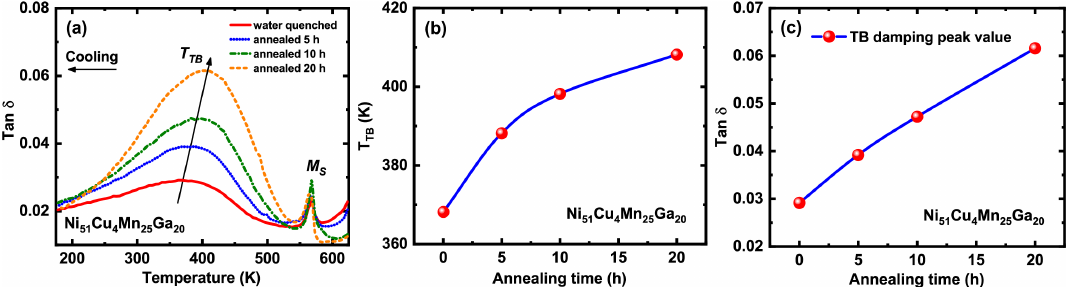
Figure 2. ( a ) Internal friction curves of water quenched and annealed Ni 51 Cu 4 Mn 25 Ga 20 samples measured at the frequency of 0.4 Hz. ( b ) Twin boundary (TB) damping peak temperature ( T TB ) as a function of annealing time. ( c ) Twin boundary damping peak value as a function of annealing